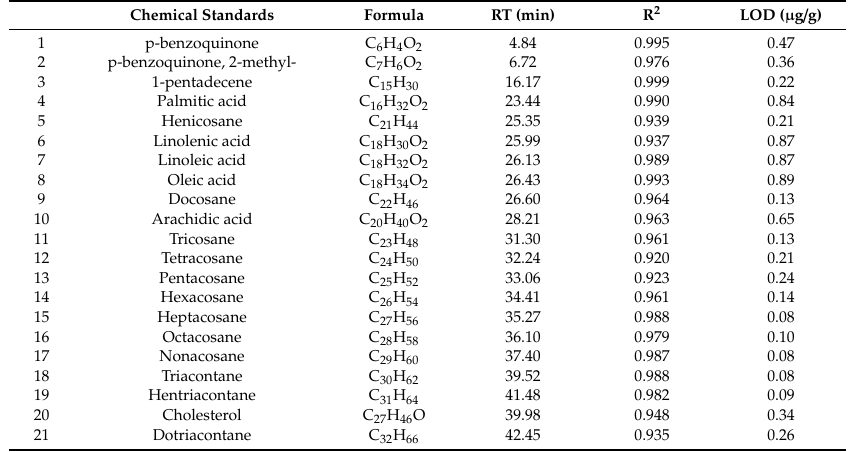
Figure 3. Hierarchical cluster analysis (heatmap) represents the data obtained from T. castaneum using eight solvents. Hot color means high gas chromatography (GC) response based on peak areas. The top dendrogram indicates the similarity among the solvents as well as the data variation among the replicates. The side arrows show that the majority of compounds were detected with high a GC response in each solvent. Table 2. The limit of detection (LOD) of external reference standards of high boiling point n-alkanes, fatty acids, sterol, p-benzoquinone, methyl-p-benzoquinone and 1-pentadecene using acetonitrile as the solvent.